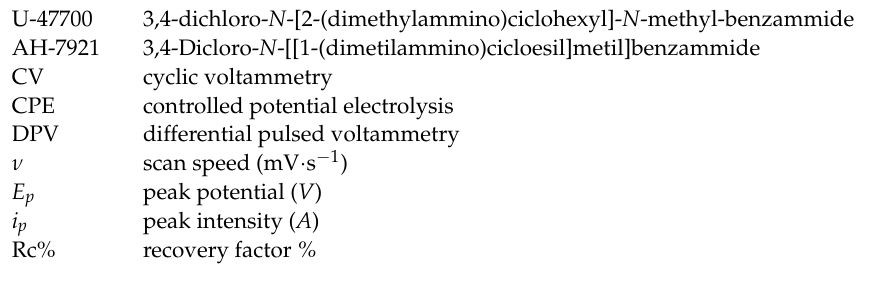
diameter; Figure S10: DPV scans of U-47700 (100 µ g · mL − 1 ), in presence of the various